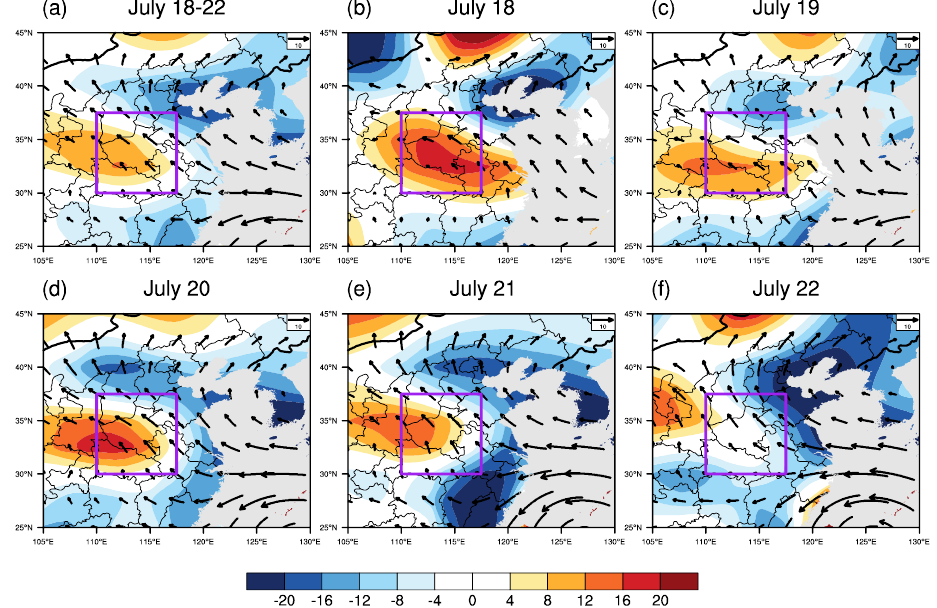
Figure 5. SameasFigure3, butforthe850hPawind(vector, unit : m/s)andtherelativevorticityanomalies Figure 5. Same as Figure 3, but for the 850 hPa wind (vector, unit: m/s ) and the relative vorticity (shading, unit : s − 1 ). ( a ) The average and ( b – f ) the daily variation during 18–22 July 2021, anomalies (shading, unit: s −1 ). ( a ) The average and ( b – f ) the daily variation during 18 – 22 July 2021, respectively.